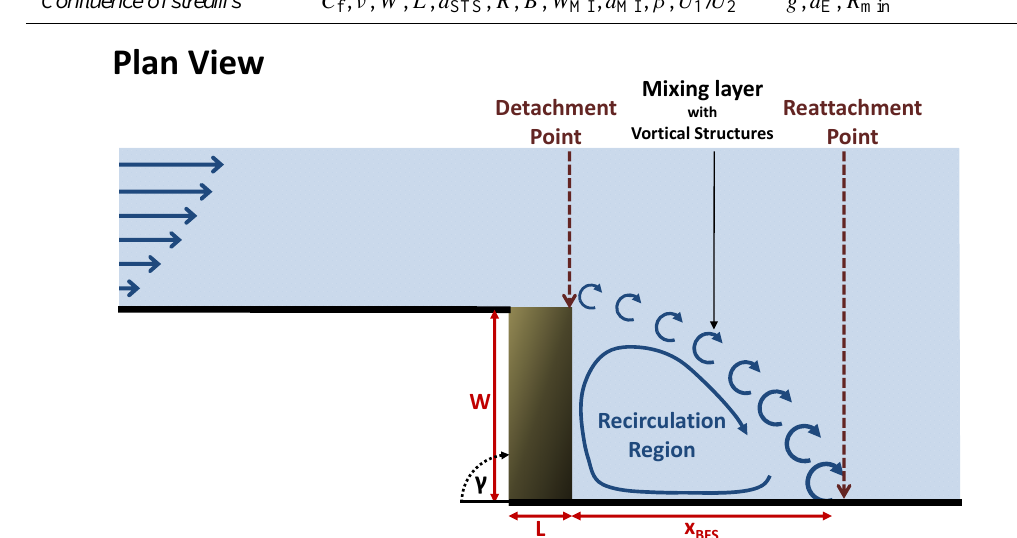
Fig. 3. Schematic of the flow field for a backward-facing step.